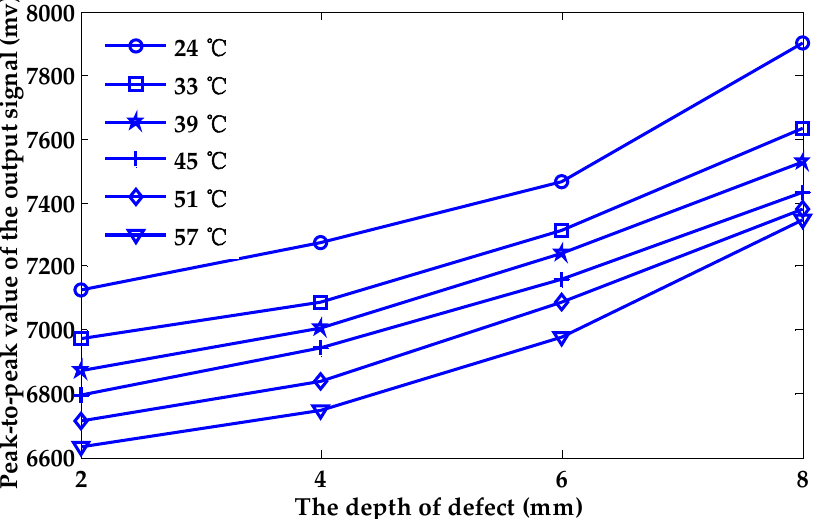
Figure 6. The relationship between the peak-to-peak value of the output signal and the depth of the defect at different temperatures.